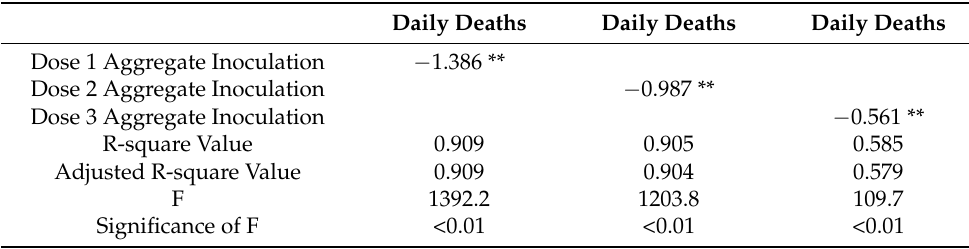
Table 11. Regression between the daily deaths and doses 1, 2, and